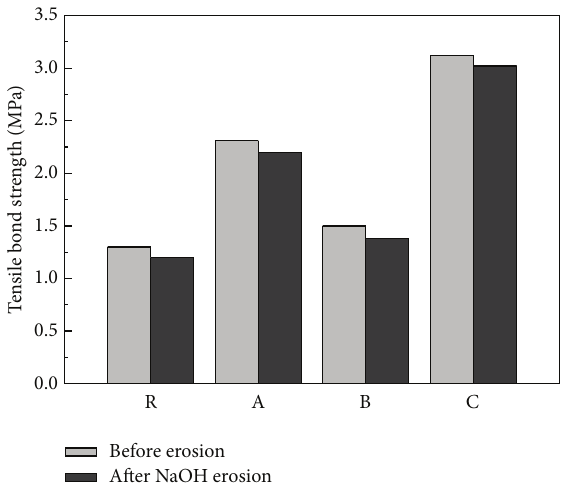
Figure 4: Tensile bond strength of repair mortars before and after erosion by saturated NaOH solution.